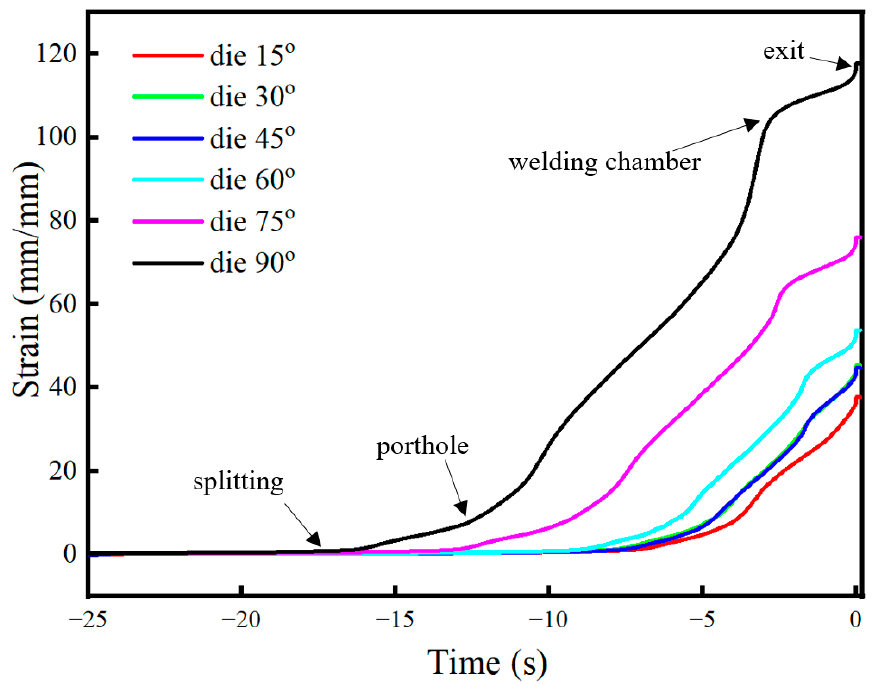
Figure 16. Model-predicted strain history at the mid-thickness of the weld seam for different lower bridge angles in the extrusion process.